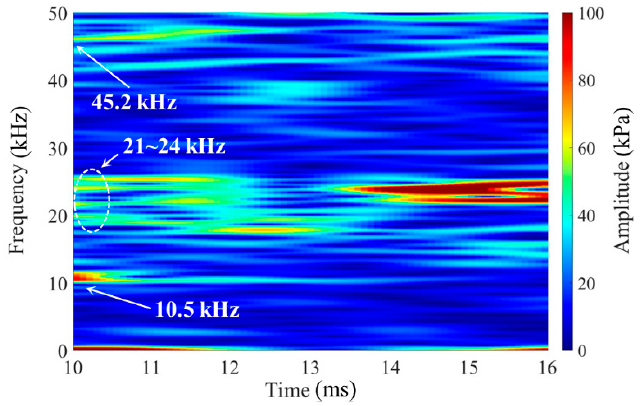
Figure 10. Plots of the ( a ) pressure history and ( b ) fast Fourier transform (FFT) result of the pressure history during combustion instability. Energies 2021 , 14 , x FOR PEER REVIEW